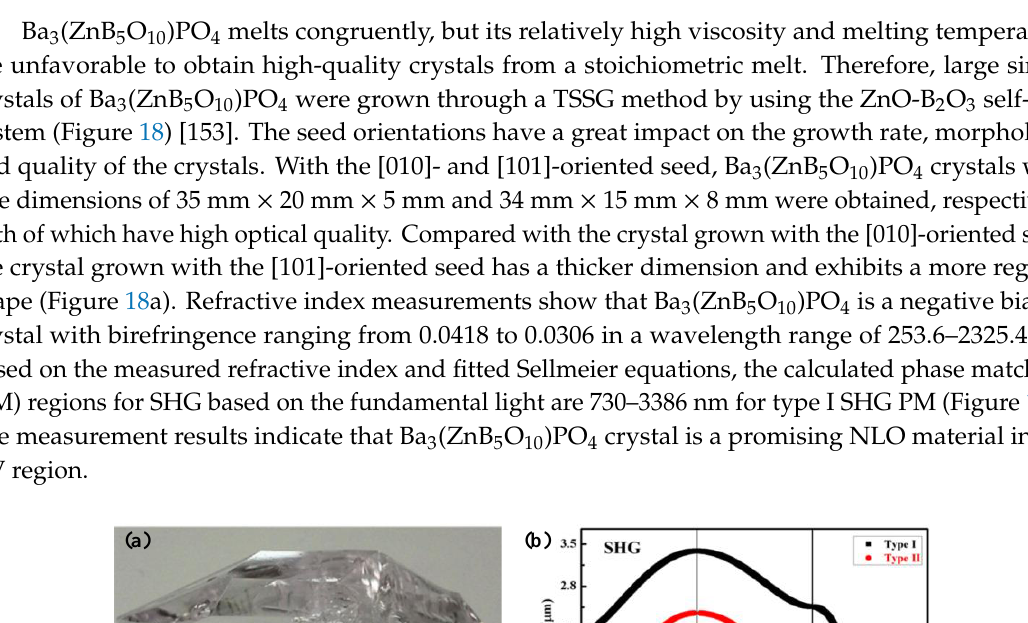
Figure 17. ( a ) Photograph of Bi 2 ZnOB 2 O 6 crystal grown by the top-seeded solution growth (TSSG) method and ( b ) Czochralski method, respectively. Reprinted with permission from Ref. [83,152], Copyright (2009) American Chemical Society, Copyright (2010) Elsevier, respectively.